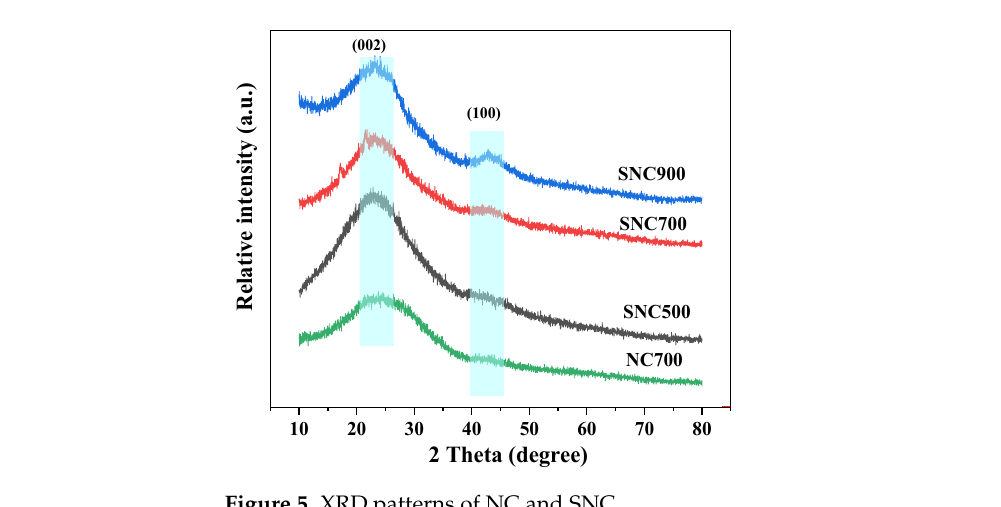
Figure 5. XRD patterns of NC and SNC.